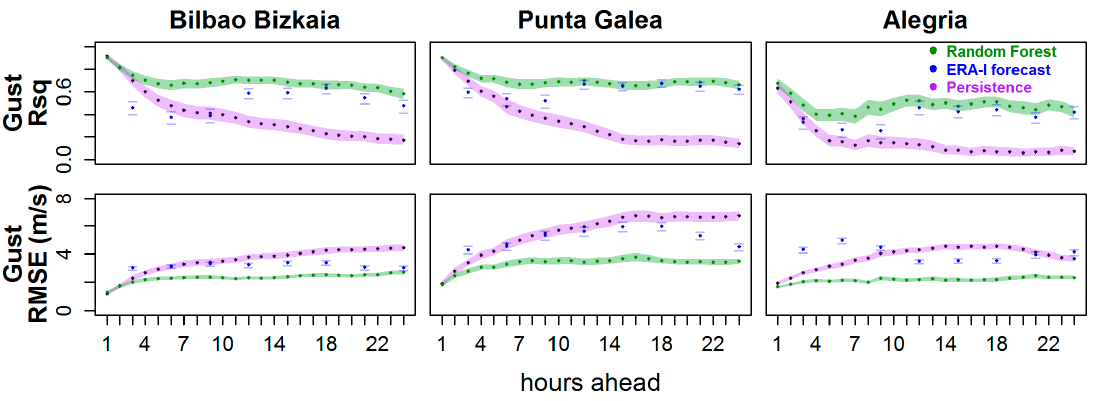
Figure 9. R 2 and RMSE verification indices for wind gust components over the coming 24 h, at three locations, and comparing three methods for the test period.